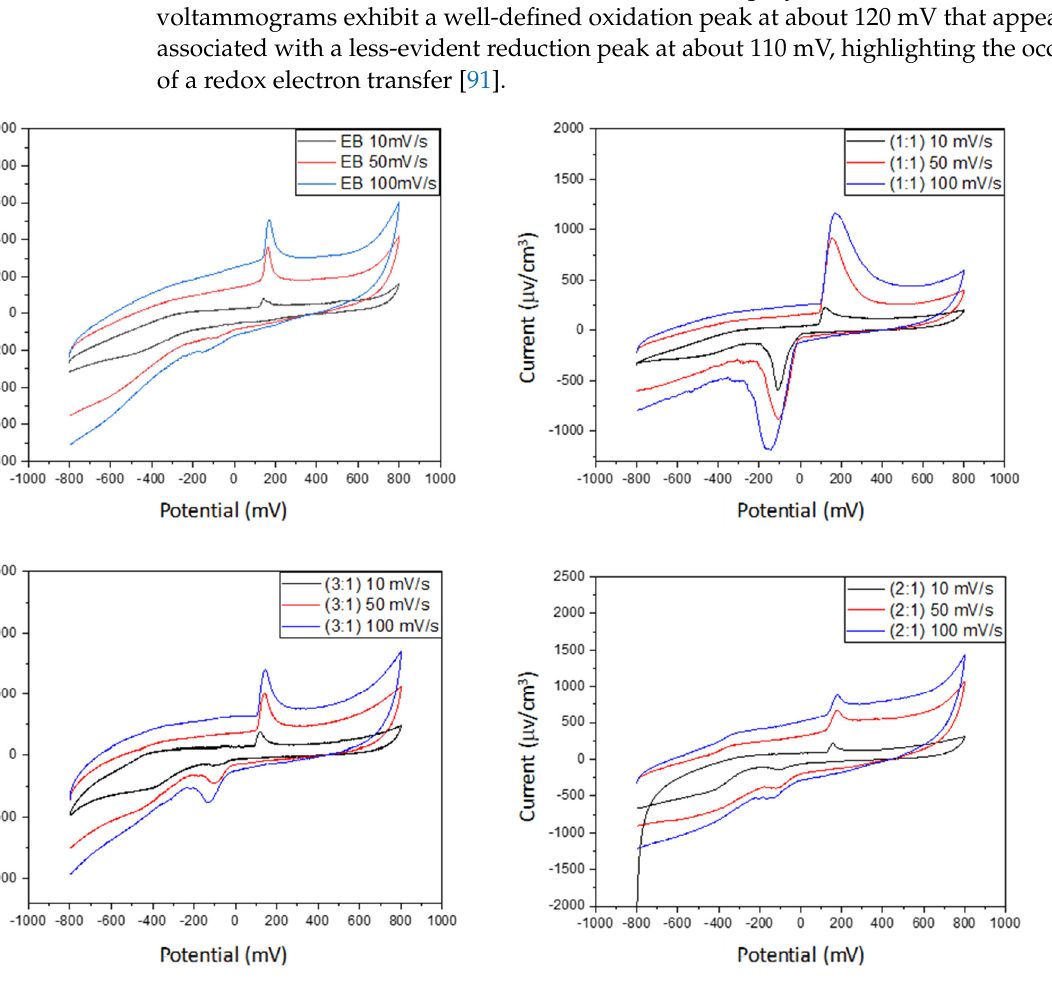
Figure 8. Cyclic voltammograms of PANI and PANI/starch